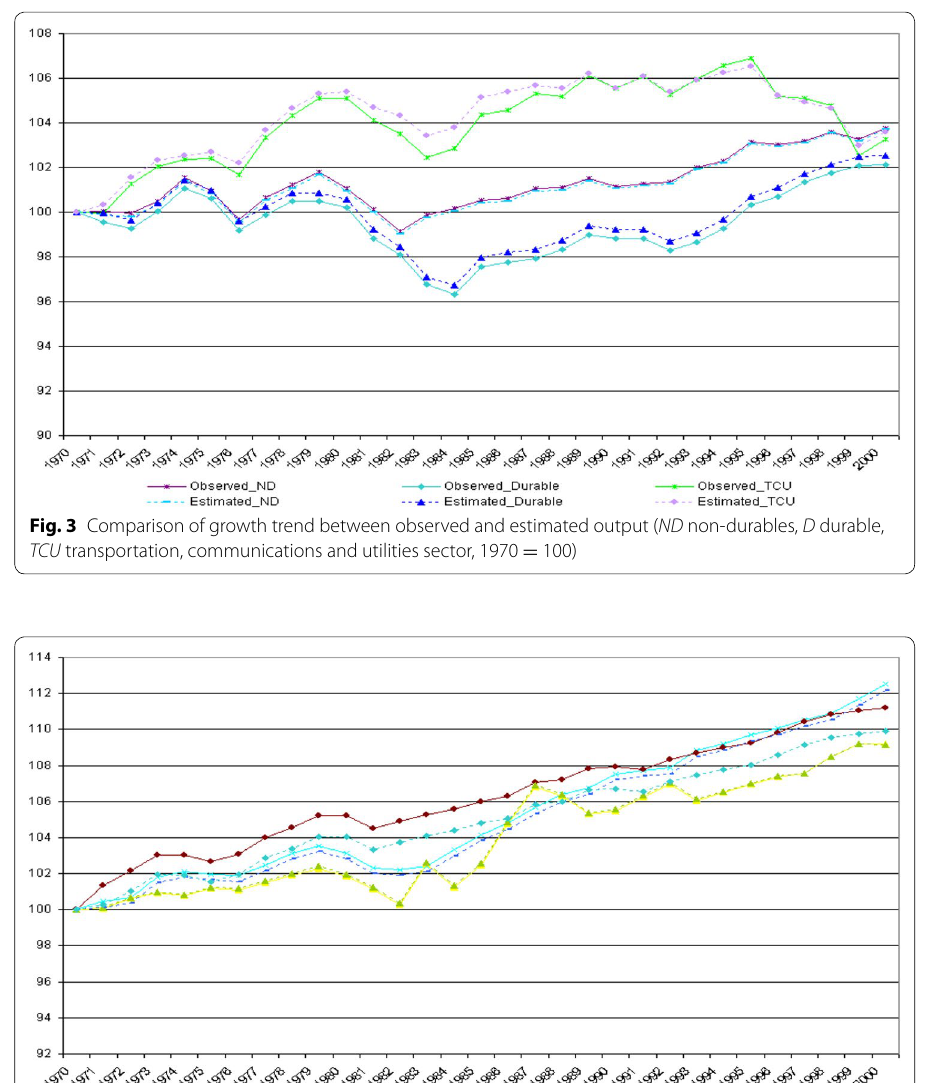
100). Note D d / dt is the time differential = =